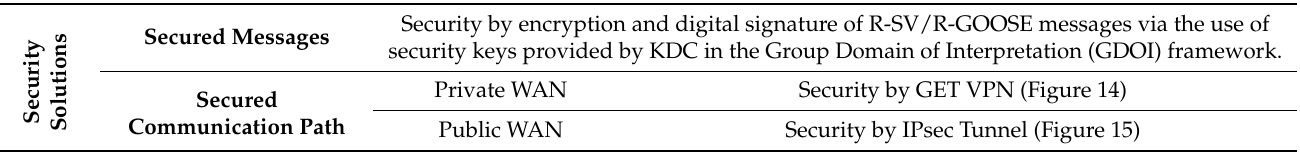
Table 3. Security solutions for R-SV/R-GOOSE communication over